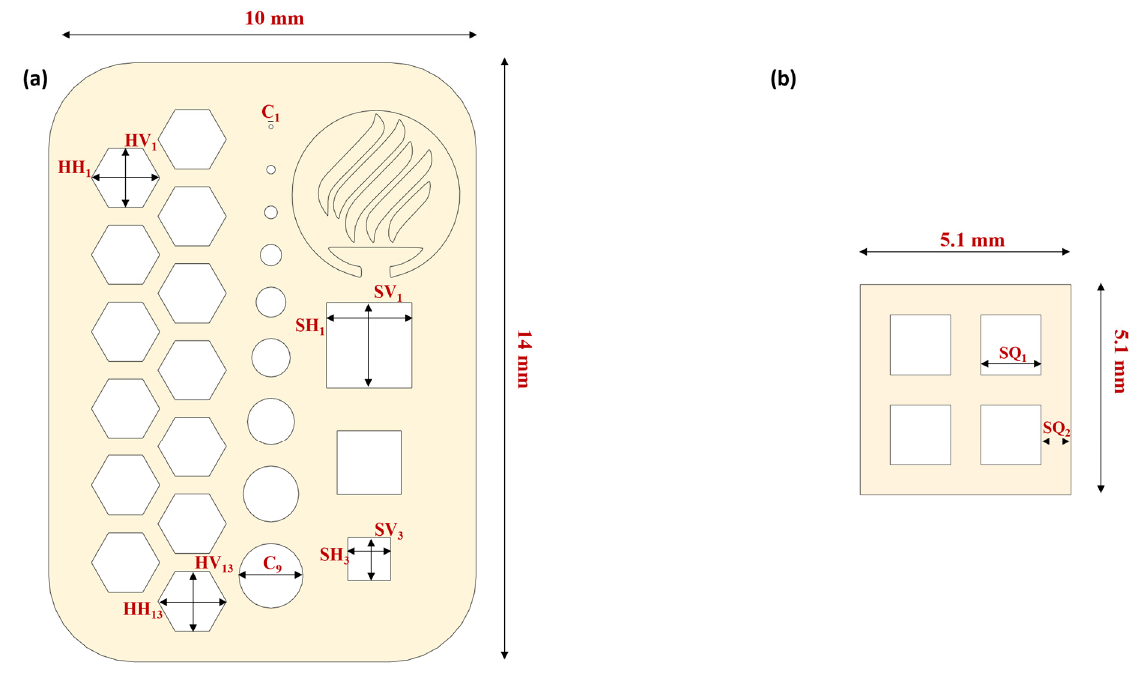
Figure 4. Resolution and cellular viability printing designs: ( a ) resolution and repeatability assessment design and ( b ) cellular viability assessment design.